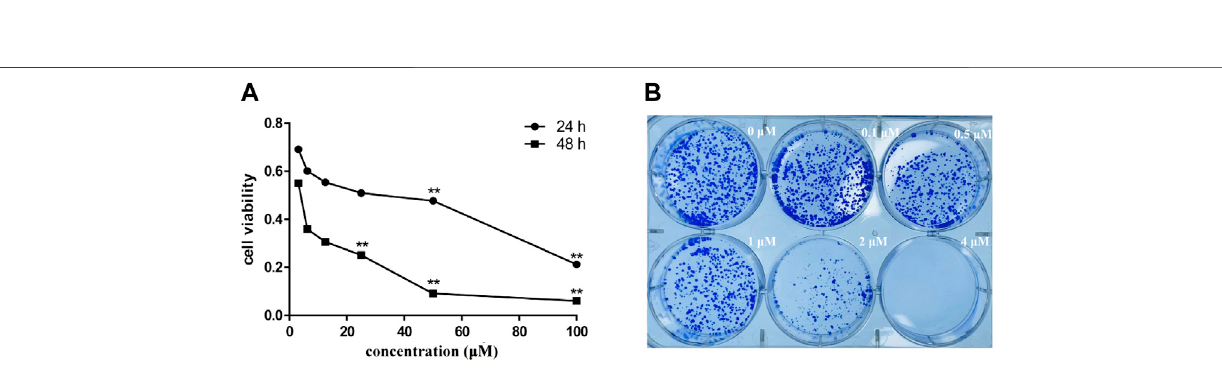
Frontiers in Chemistry |